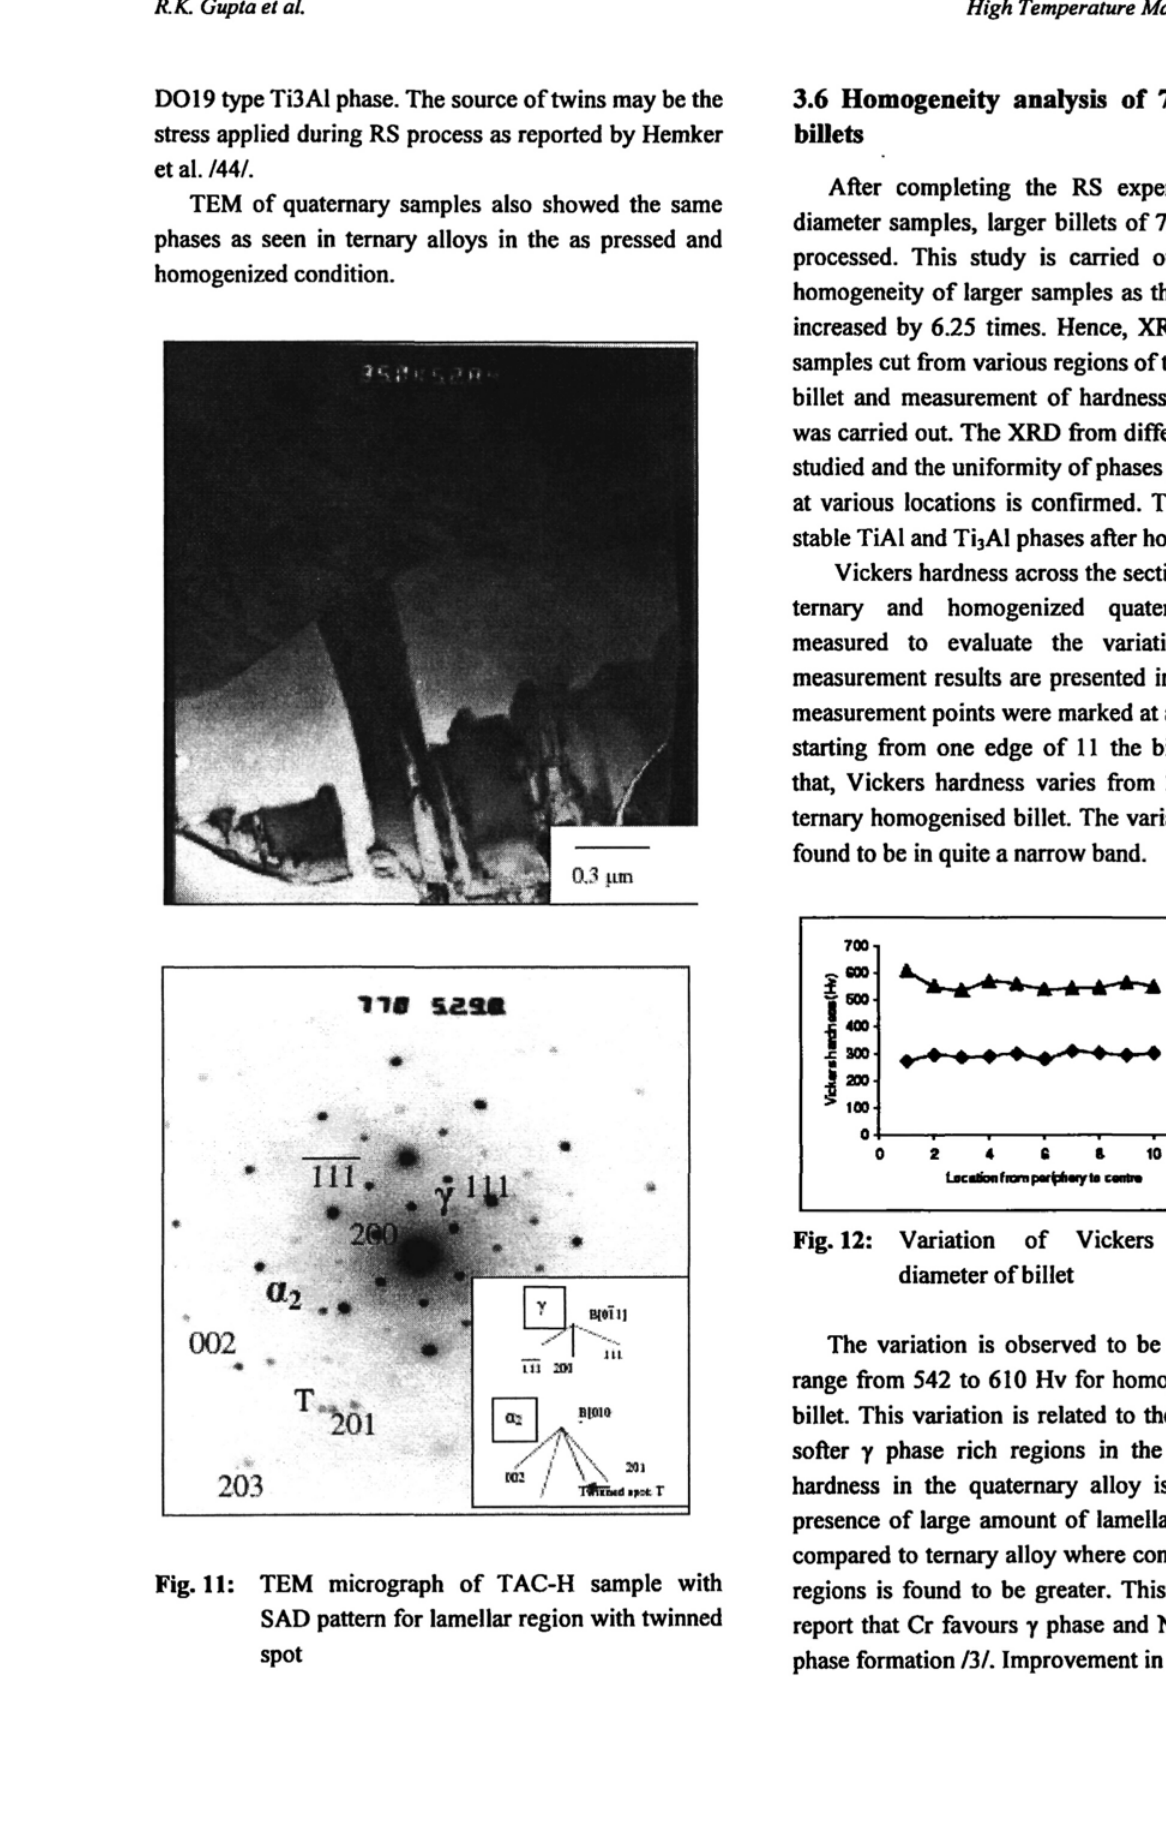
Fig. 11: TEM micrograph of TAC-H sample with SAD pattern for lamellar region with twinned spot